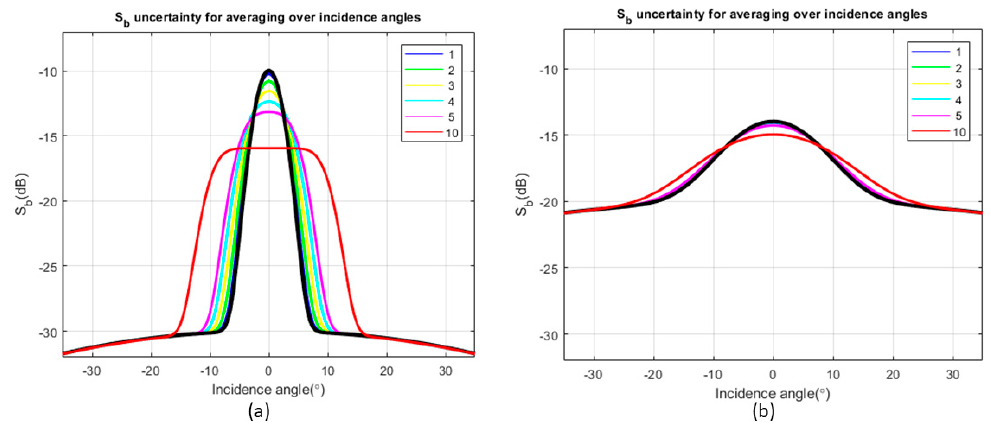
Figure 15. Effect of incident angle binning on averaged backscatter values. Two nominal angular backscatter curves representing seafloor types ( a : high narrow specular and b : low and wide specular) showing the effect of angular binning over 1 to 10° corresponding to the incidence angle standard deviation due to slope uncertainty. The impact is maximal in the specular region, where the angular binning effect corresponds to the strongest angular variations (0° to 15° incidence angles); it is then negligible in the “plateau” angle sector (>15° incidence angles).